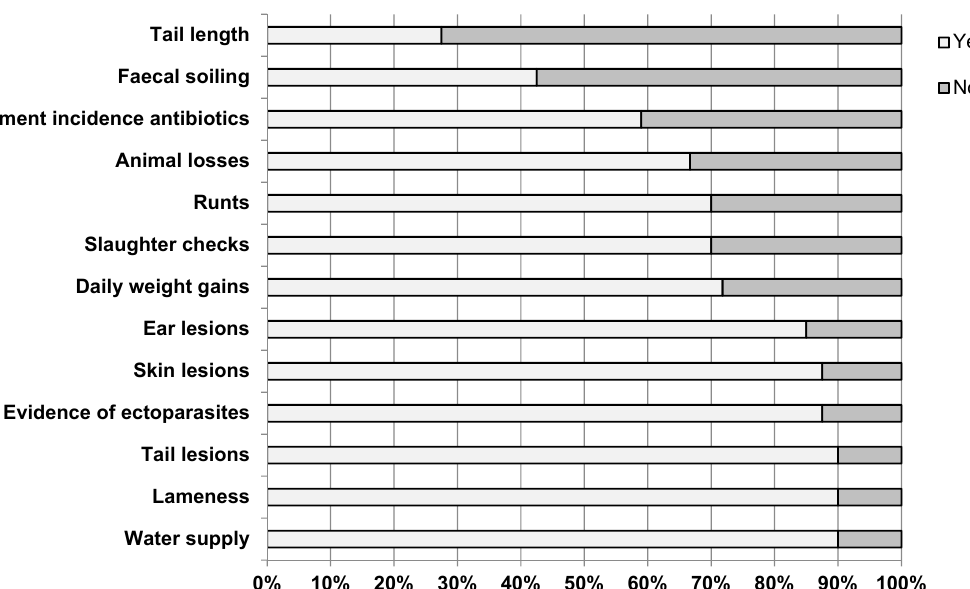
Figure 1. Farmers’ response to the question whether the 13 indicators can be considered as indicative with respect to fattening pig welfare or not (n = 40 responses, except for the indicators animal losses, treatment incidence antibiotics and daily weight gains n = 39 responses).